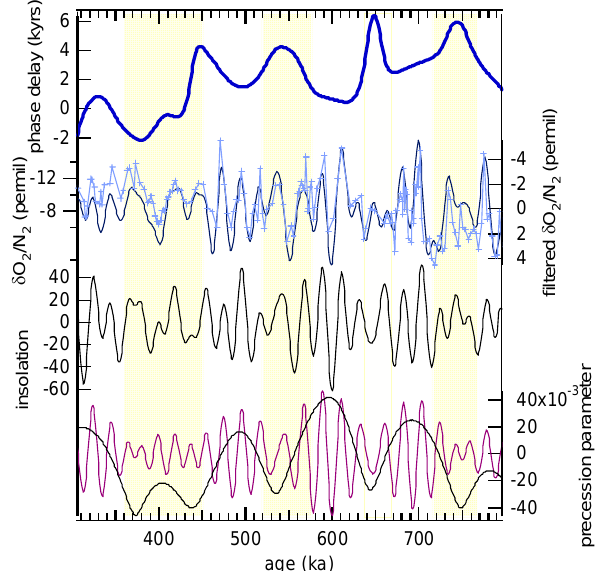
vs. insolation. Time periods with low eccentricity are highlighted in grey.